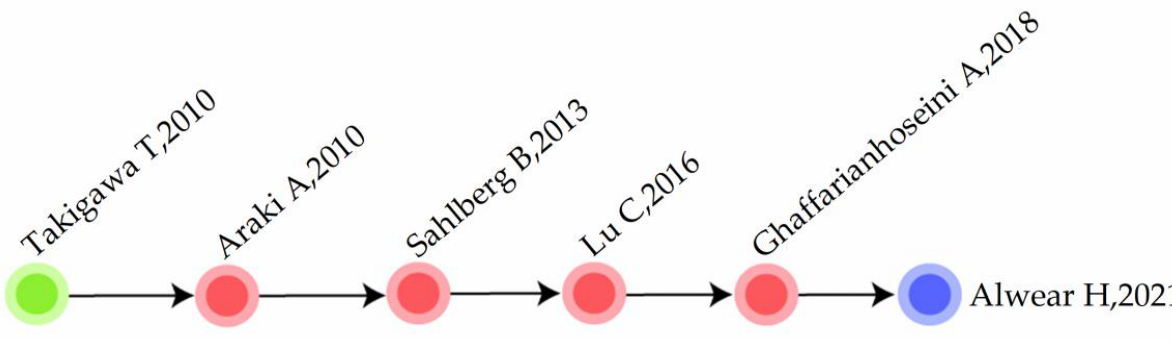
Figure 10. Phase path analysis of the SBS from 2010 to 2022 [39 – 41,46 – 48].